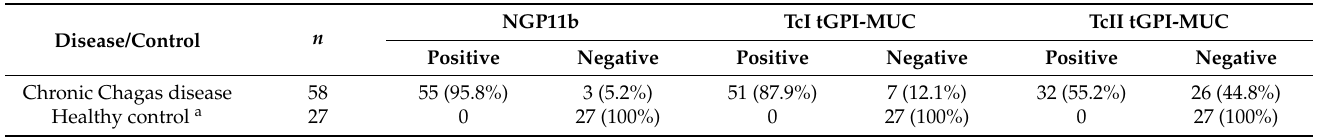
Table 1. Immunoreactivity of sera of CCD patients and plasma of negative controls with TcI tGPI- MUC, TcII tGPI-MUC, and